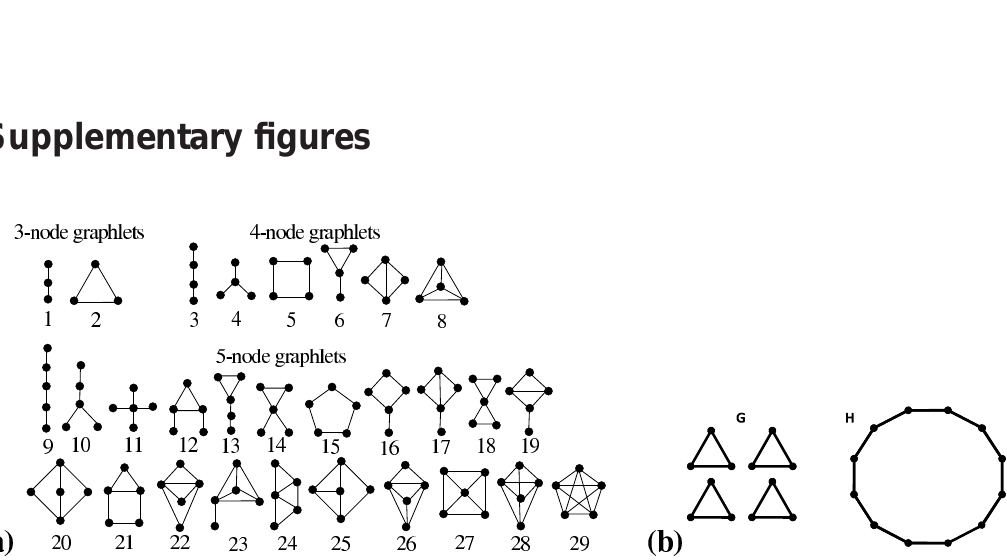
Figure S1: (a) All 3-node, 4-node, and 5-node graphlets [1]; ( b) an example of two networks of the same size, G and H , that have the same degree distribution, but very different network